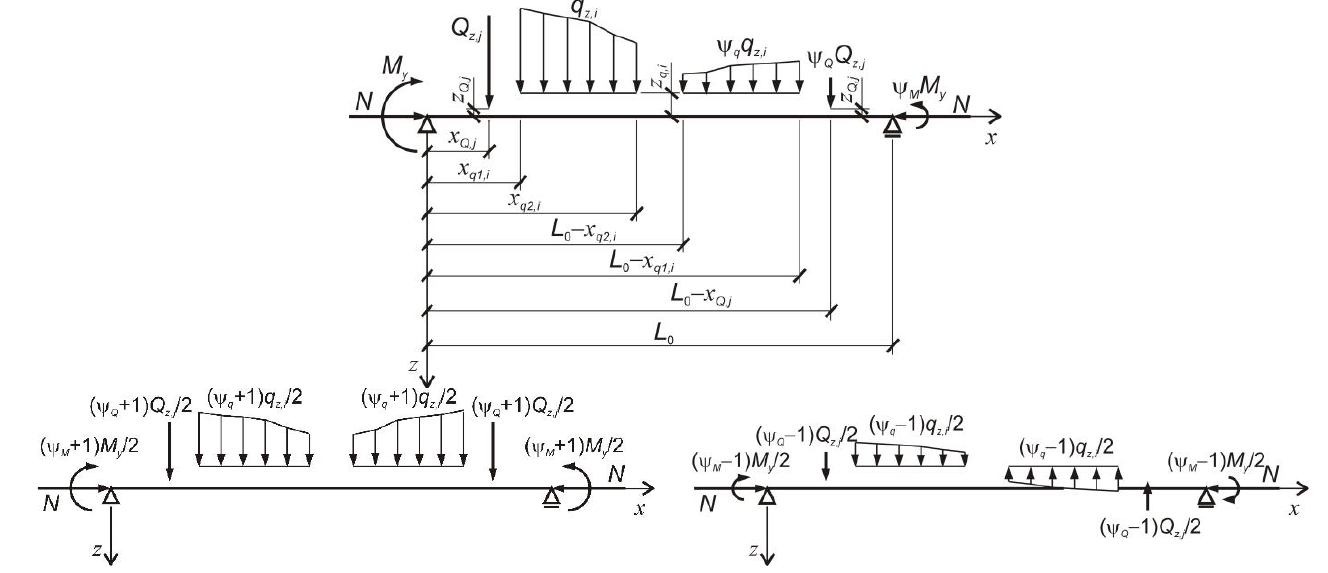
Figure 3. In-plane loading system considered, and its decomposition into symmetric and anti- symmetric components.